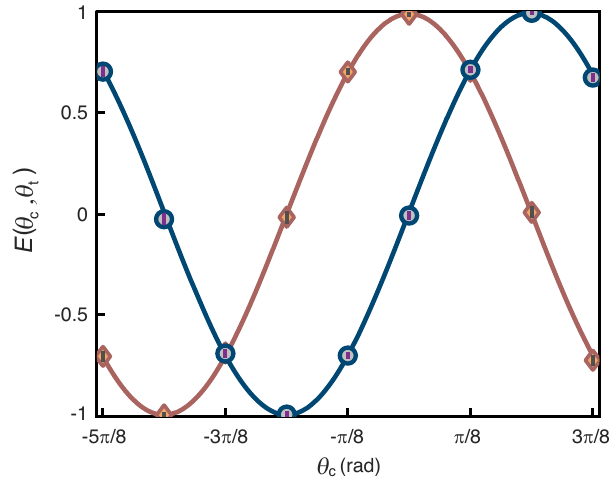
Fig. 4 | Entanglement created by the quantum logic gate. Measured correlation function E ( θ c , θ t ) as a function of θ c with θ t =0 (diamonds) and θ t = π /4 (circles). Solidcurvesaresinusoidal fi tswith0.99(1)visibility.Theerrorbarsrepresentthe1 σ standard deviation from photoelectric counting